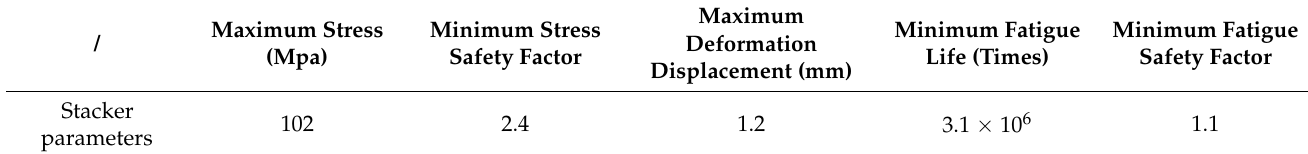
Table 4. The parameters of a software development instance.